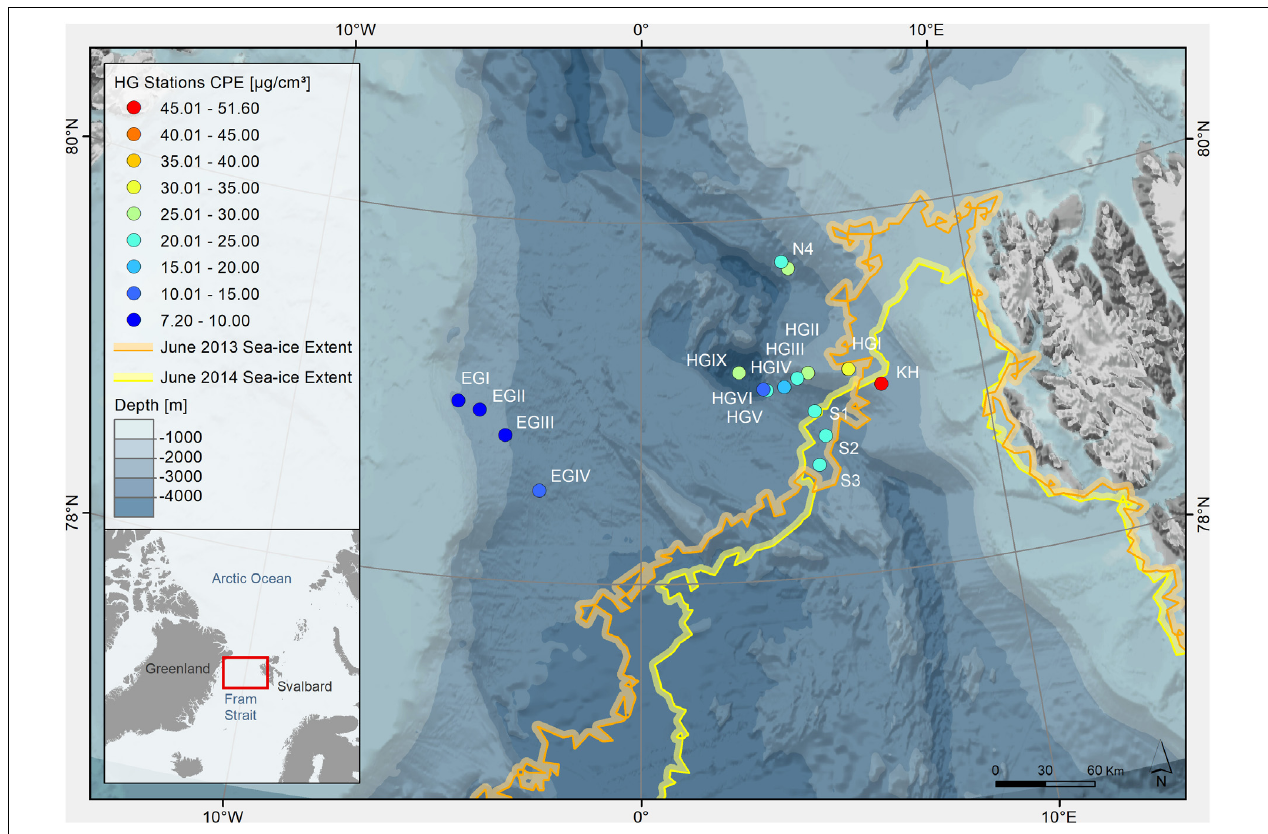
FIGURE 1 | Bathymetric map of the Arctic Ocean indicating sampling stations at the LTER observatory HAUSGARTEN (Fram Strait). The color of the dots indicates concentrations of chloroplastic pigment equivalents (CPE) in surface sediments (0–1 cm, in µ g/cm 3 sediment indicated on the color legend on the left). The colors of the lines indicate the location of the sea ice margin during each sampling year, defined as > 15% ice coverage ( Supplementary Table S1 ).